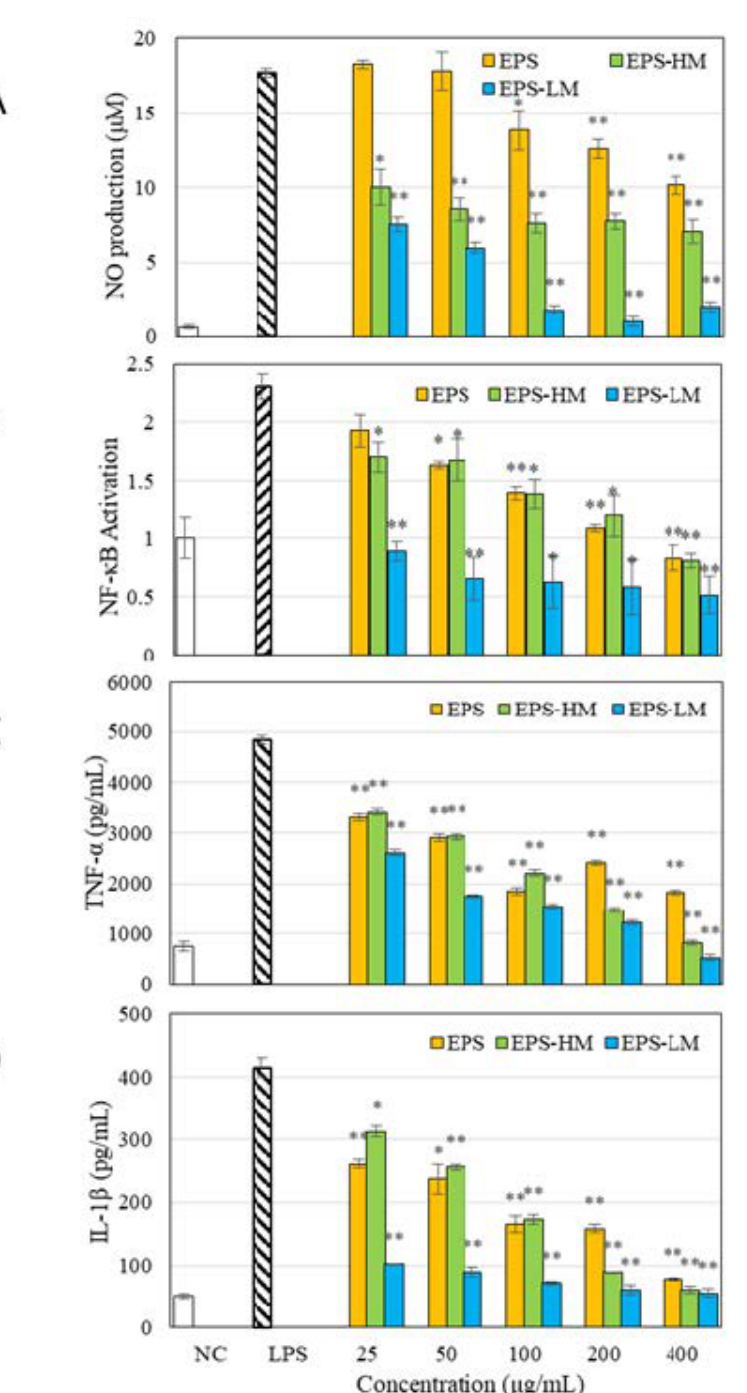
Figure 1. Effects of three different EPS fractions on LPS-induced inflammatory responses in THP-1 cell culture: ( A ) NO production; ( B ) NF- κ B activation; ( C ) TNF- α cytokine release; ( D ) IL- β cytokine release. * and ** indicate statistically significant differences from the LPS group at p < 0.05 and p < 0.01 by the Student t -test,